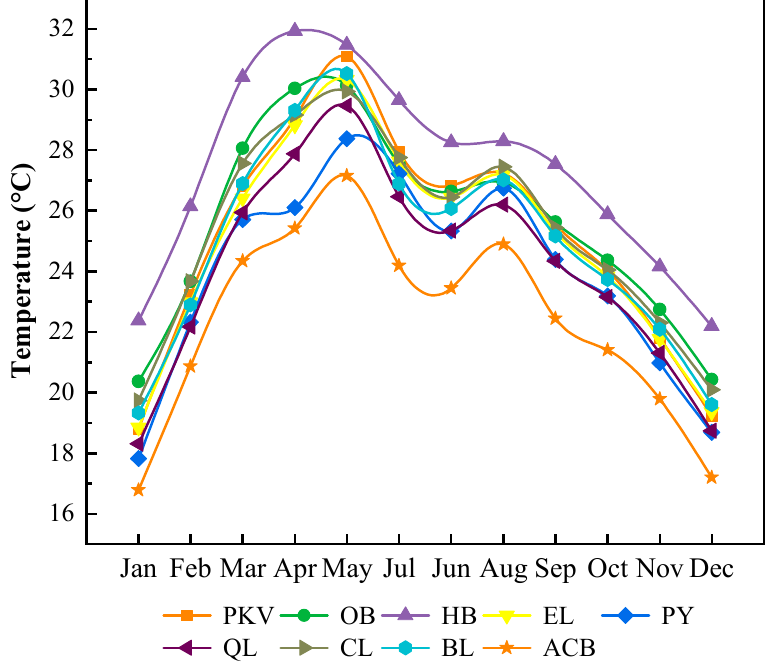
Figure 13. Average monthly land surface temperature statistics of different tree species in the study area.